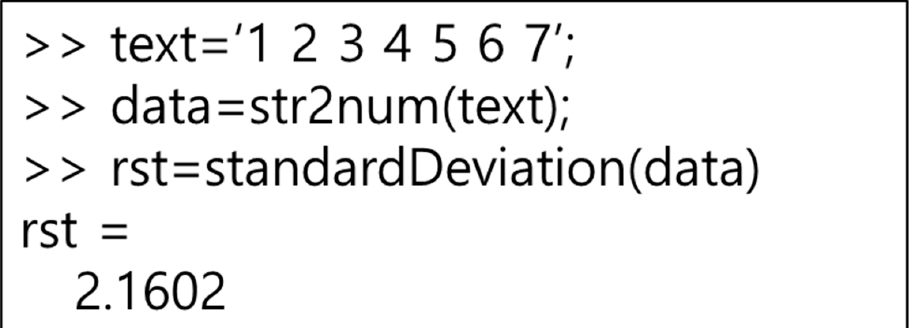
Figure 9. MATLAB function execution command.